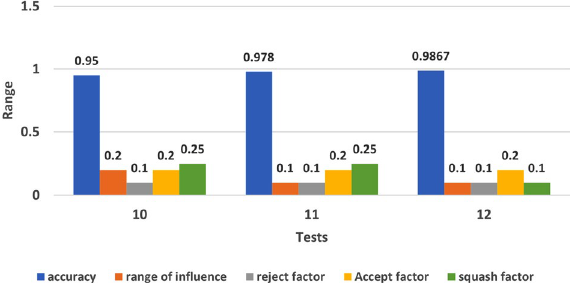
Figure 7. The best parameters values from previous test in tests 10, 11 and 12.